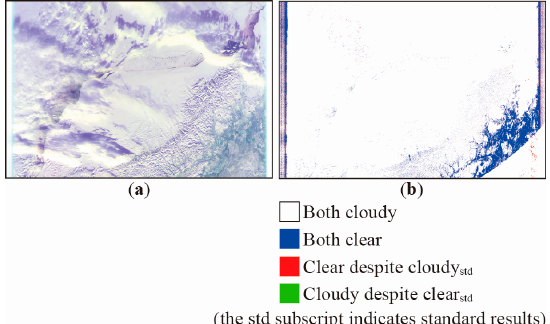
Figure 6. Comparative results for Alaska on 1 March 2014. ( a ) Input CAI L1B product (R: Band 2, G: Band 3, B: Band 1); ( b ) Comparative results for the SV generated by Procedures 1 and 2 when using the SV generated by Procedure 1 as a standard. The right lower border is caused by the conversion of features from land or water cloud tests to polar cloud tests.